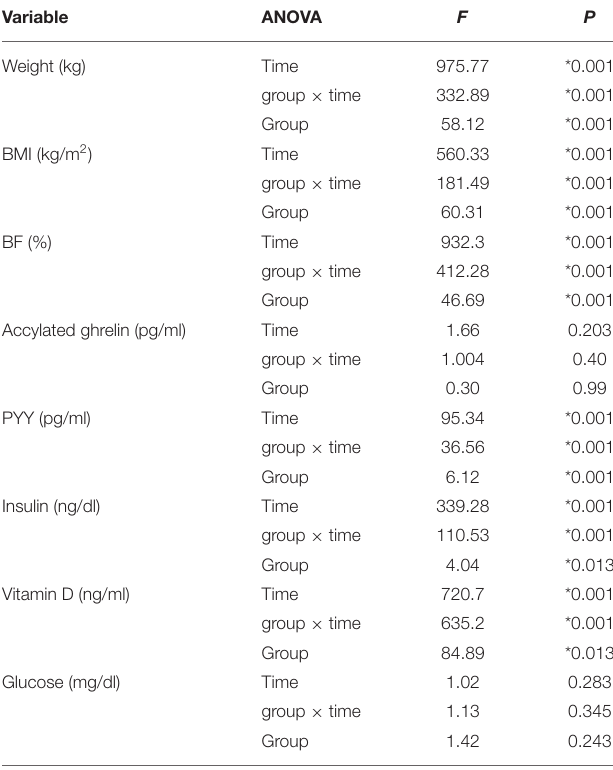
TABLE 5 | The ANOVA test results regarding research